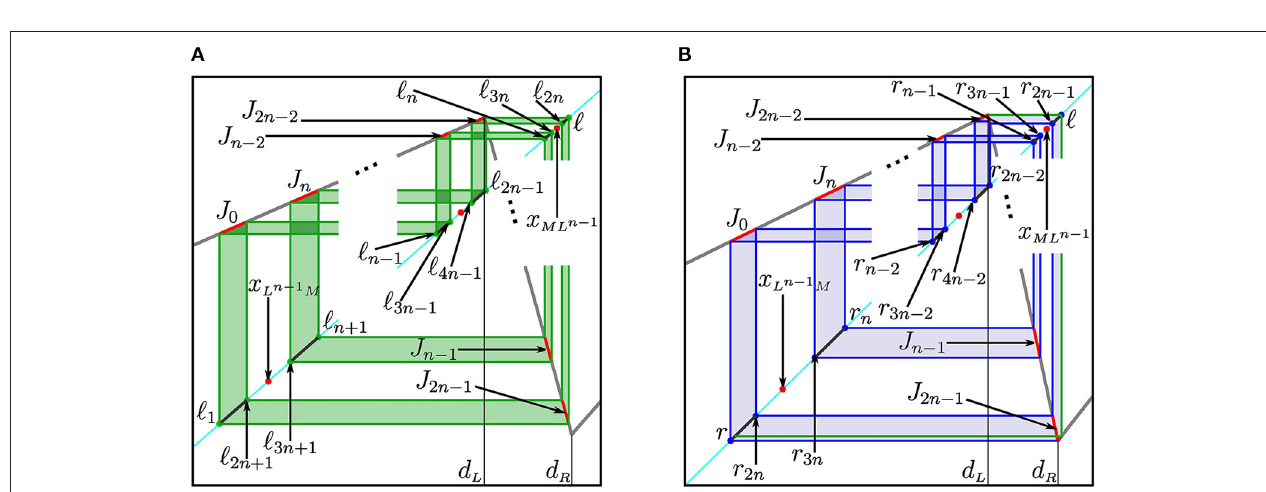
FIGURE 7 | Schematic representation of function f and 2 n-cyclic chaotic intervals Q 2 n before the merging bifurcation of Q 2 n for (A) p ∈ D 1 ; (B) p ∈ D 0 .